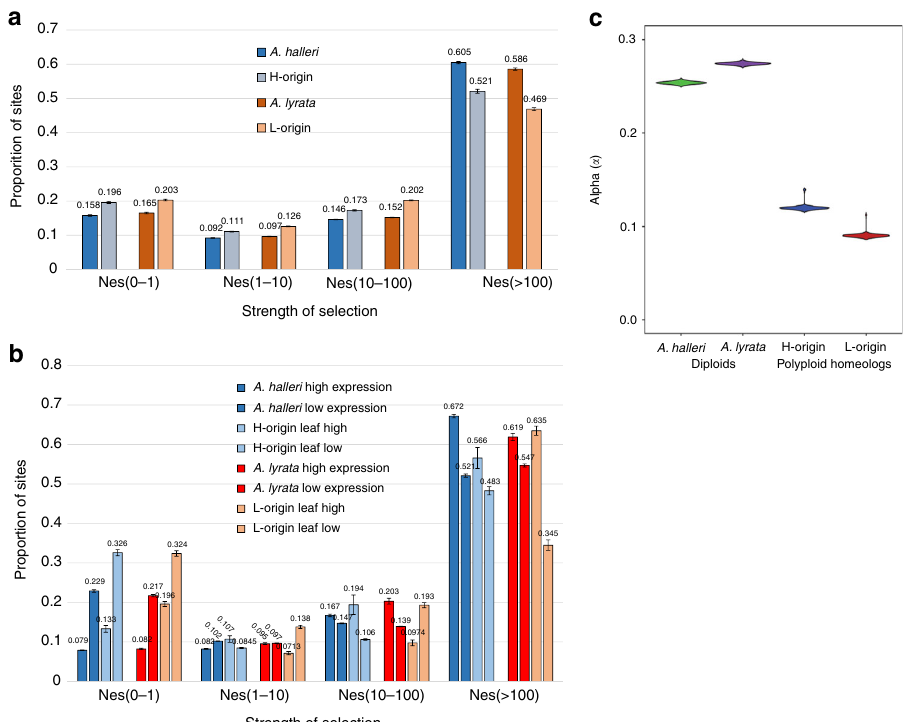
Fig. 4 The strength of purifying selection and adaptive evolution. a The distribution of fi tness effects (DFE) of deleterious mutations for coding sequences of the two A. kamchatica subgenomes and corresponding diploid orthologs of A. halleri and A. lyrata . The strength of selection is indicated by N e s where N e is the effective population size and s is the selection coef fi cient. Error bars show sd. b DFE categorized by expression in both subgenomes and diploid species. Expression categories were taken from the upper 10% (high) and lower 10% (low) of expression distribution in all A. kamchatica homeologs. The DFE was estimated from 10 6 MCMC replicates. Error bars are sd from 1000 resampled MCMC replicates. c The proportion of adaptive non-synonymous substitutions ( α ) for both subgenomes (H-origin α = 0.12, CI: 0.117 – 0.141, L-origin α = 0.09, CI: 0.087 – 0.094) and for the two corresponding diploid species ( A. halleri α = 0.25, CI: 0.251 – 0.257, A. lyrata α = 0.27, CI: 0.272 – 0.277) are signi fi cantly greater than